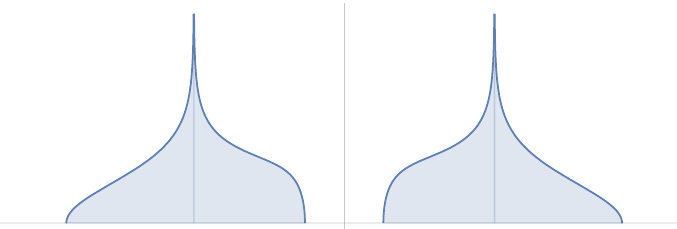
Figure 4 . Pro(cid:12)le of the spectral density ρ ( t ) in regime II.